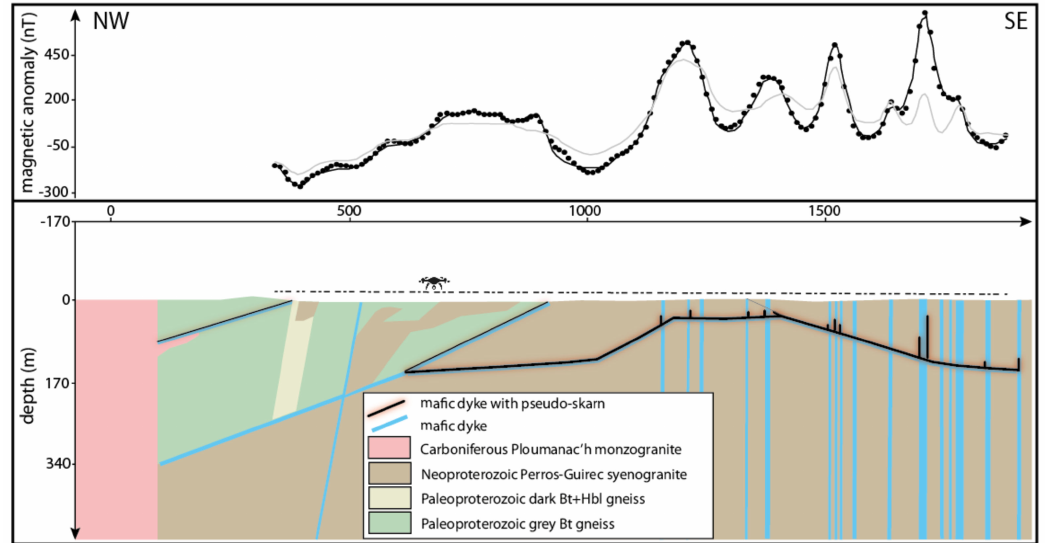
Figure 9. Final magnetic model along the coast. Upper window: UAV-borne measured magnetic anomaly (dots) compared to the computed magnetic model effect (line). Lower window: colors of modelled geological units are consistent with Figure 2. 1st and 3rd dolerite dyke generations are modelled as 2D subvertical sheets; their magnetic effect only cannot account for the entire magnetic signal (grey line in upper panel). For the final fit of the magnetic data (black line in upper panel), pseudo-skarn mineralization (in black with red shadow—exaggerated in size) was modelled channeled along some of the vertical dolerite dykes, in connection with the mineralized 2nd generation low-dipping mafic